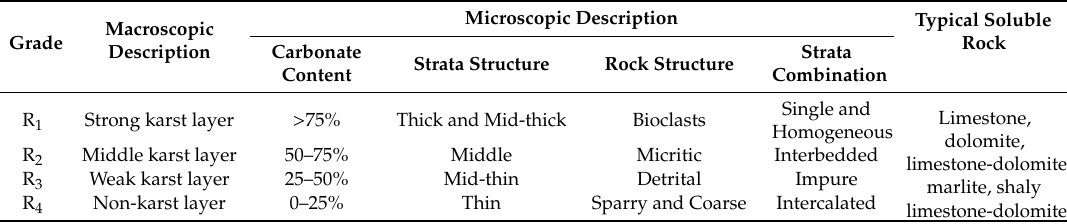
Table 1. Risk grade division criteria for stratum